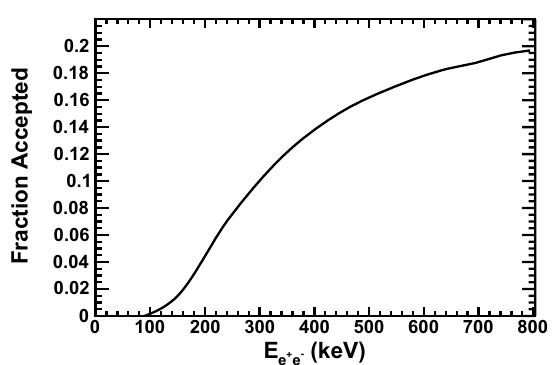
Figure 8. The total acceptance of our detector to e + e − pair particles, given as a fraction of accepted events, over the available energy range of the produced pair. This folds together the kinematic, trigger, and timing window cut efficiencies.